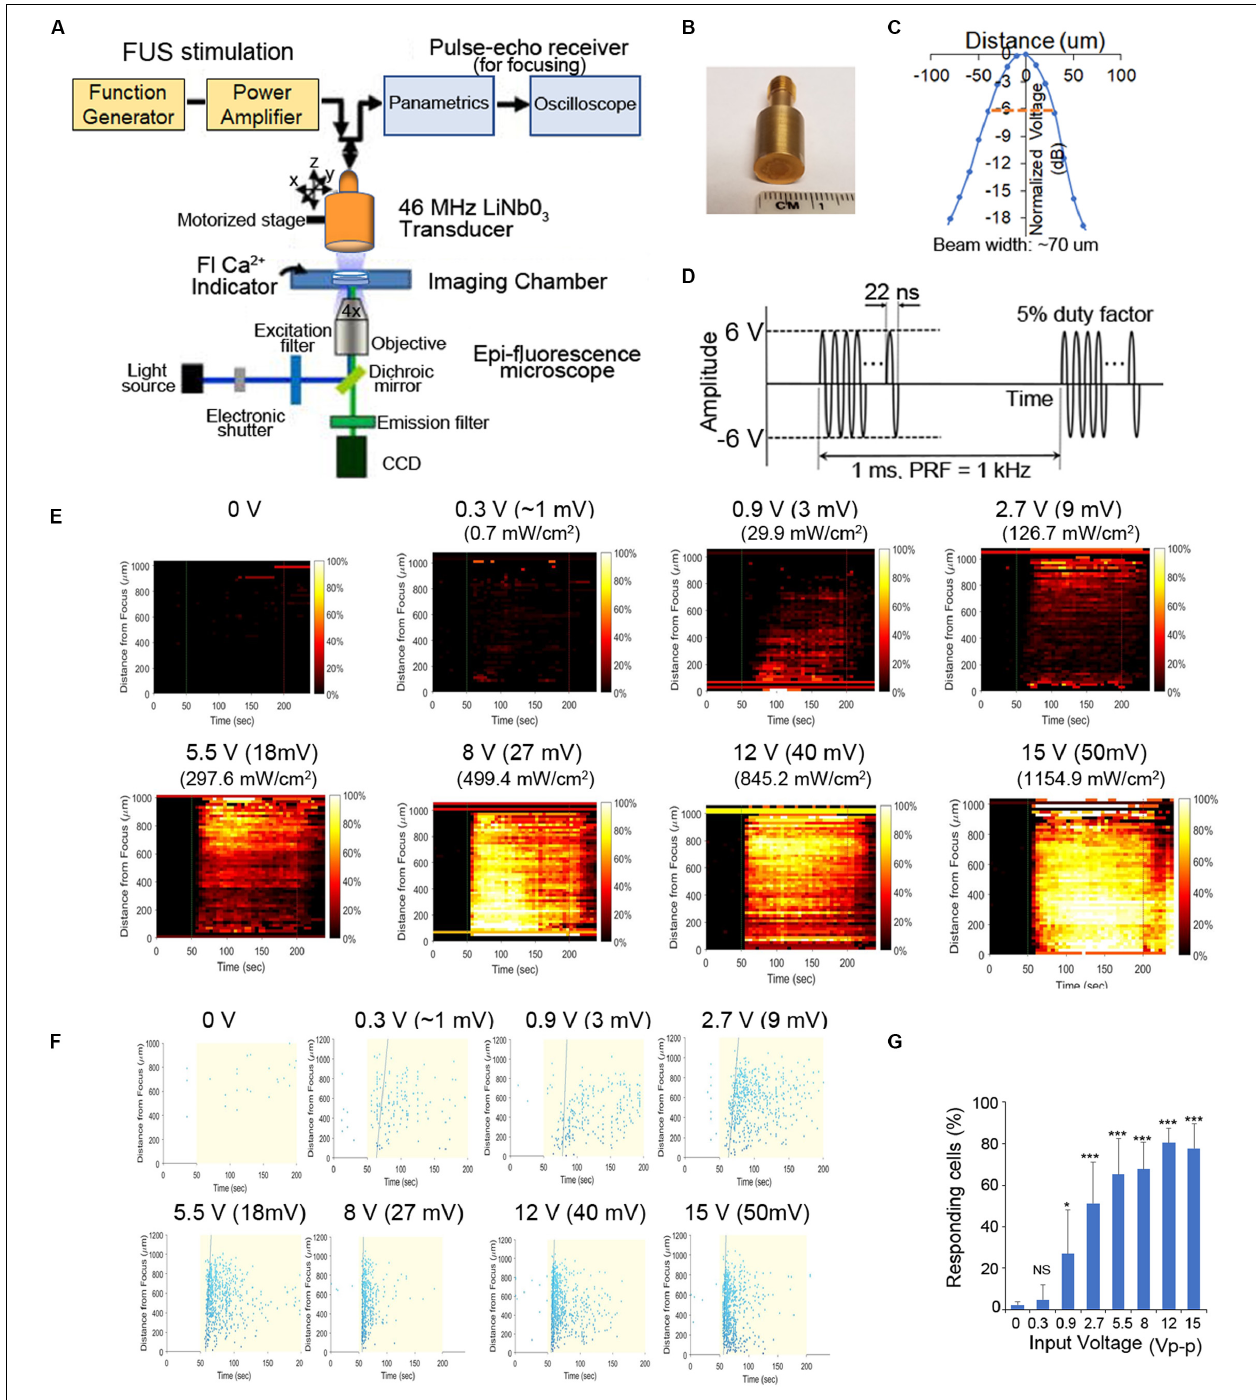
FIGURE 1 | Schematic of our experimental system and effect of FUS stimulation amplitude on PC-3 Ca 2 + response. (A) A 46-MHz, single-element, LiNbO 3 , press-focused transducer was used for FUS stimulation and focused with a pulse-echo receiver. Cells were imaged using epi-florescence microscopy in the presence of a Ca 2 + indicator. (B) Photograph of the 46-MHz transducer used in most experiments. (C) The beam width produced by the transducer was measured by hydrophone and was ∼ 70 µ m. (D) Typical voltage waveform used to drive the transducer. Carrier frequency had an amplitude of 46 MHz (12 Vp–p), pulse repetition frequency was 1 kHz and duty cycle was 5%. (E,F) Effect of FUS stimulation amplitude on PC-3 Ca 2 + response. Standard stimulus parameters (D) were used while varying the transducer input voltage. All stated voltages represent peak-to-peak amplitude (Vp-p). Values in parentheses indicate the mV and Ispta at each voltage, as measured by a hydrophone. (E) 2-D histograms showing the percentage of responding cells over time. (F) Scatter plots showing the time at which each individual cell first responds. (G) Quantitative percentage of responding cells. n > 3 biological replicates. Error bars, SEM., * P < 0.05; ** P < 0.01; *** P < 0.001 by a one-tailed t -test. n represents biological